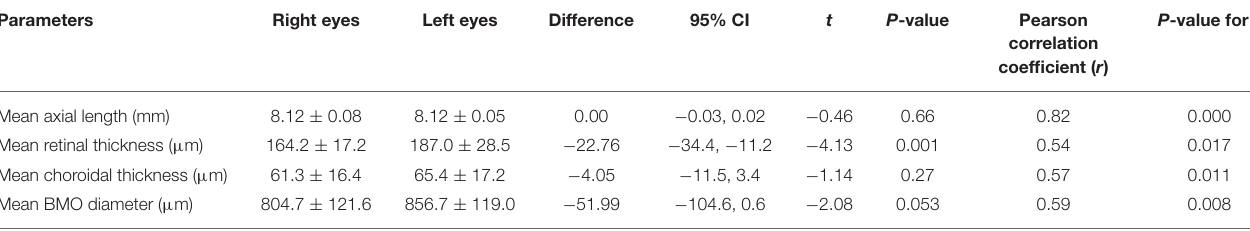
TABLE 1 | Interocular analysis showing the difference of measurements between the right eyes and left eyes in guinea pigs. Parameters